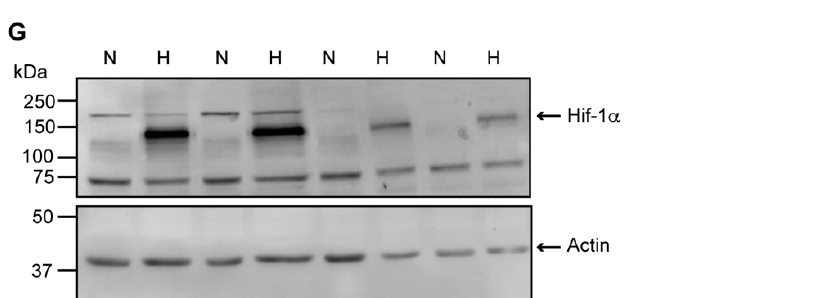
Figure 3. mCCD cl1 cells display up-regulation of hypoxic markers. Relative mRNA expression levels of ( A ) Egln1 , ( B ) Egln3 , ( C ) Vegfa , ( D ) Slc2a1 , ( E ) Pag1 , and ( F ) Serpine1 in mCCDcl1 cells in normoxia (N) and following 24 h of hypoxia (H) ( n = 4 per condition in ( A – C , E ), n = 3 per condition in ( D ) and ( F ) secondary to insufficient RNA for one sample). ( G ) Representative immunoblots of Hif-1 α in protein lysates of mCCD cl1 cells under normoxia (N) or following 24 h hypoxia (H). β − actin was used as loading control. * p < 0.05, ** p < 0.01.